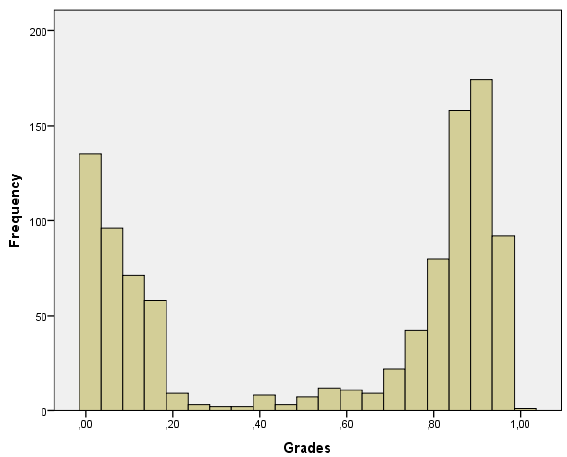
Figure 1. Distribution of PM MOOC participants’ final